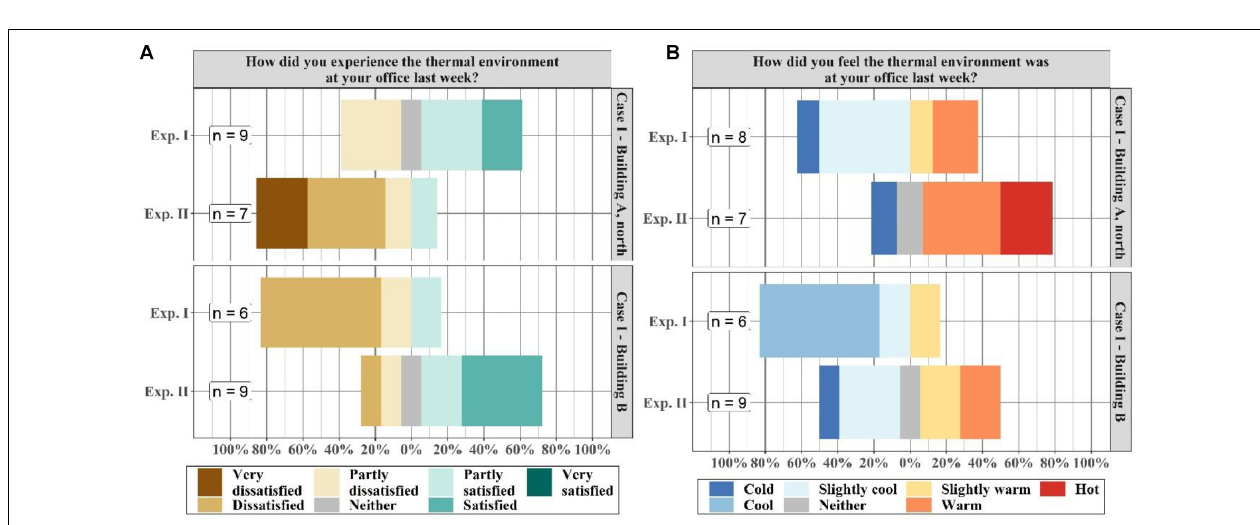
FIGURE 8 | Median, 25th and 75th percentile score for each monthly questionnaire in case II related to how much respondents agreed or disagreed with following statements regarding their motivation for voting with TiAQ.